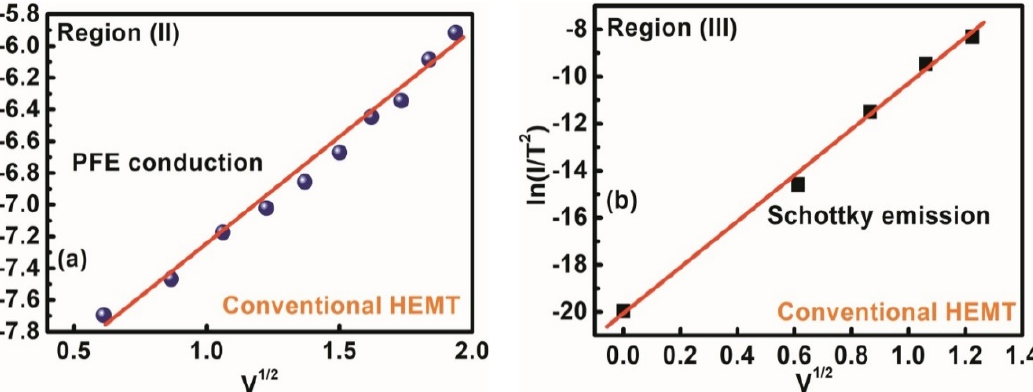
Figure 11. Gate leakage conduction mechanism of the conventional HEMT ( a ) region II, ( b ) region III.